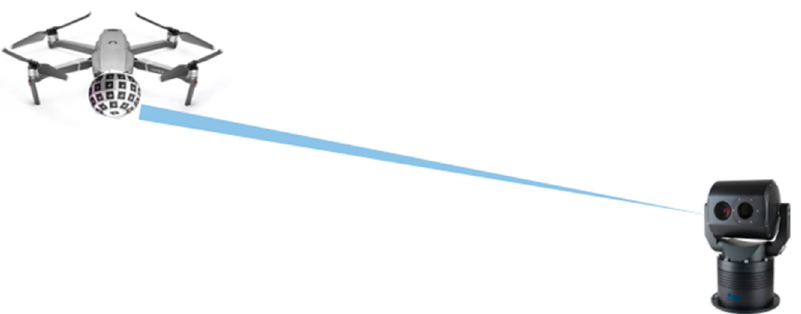
Figure 1. One-way communication link.